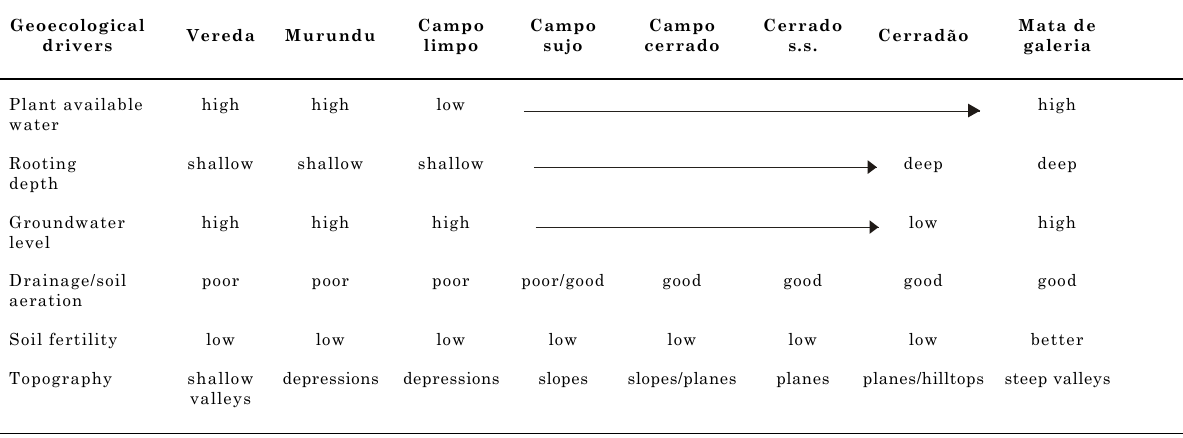
Table 2. Simplified relationship between vegetation formations and geoecological drivers in the study region. Arrows represent a gradient Campo Campo Geoecological Vereda Murundu drivers limpo sujo